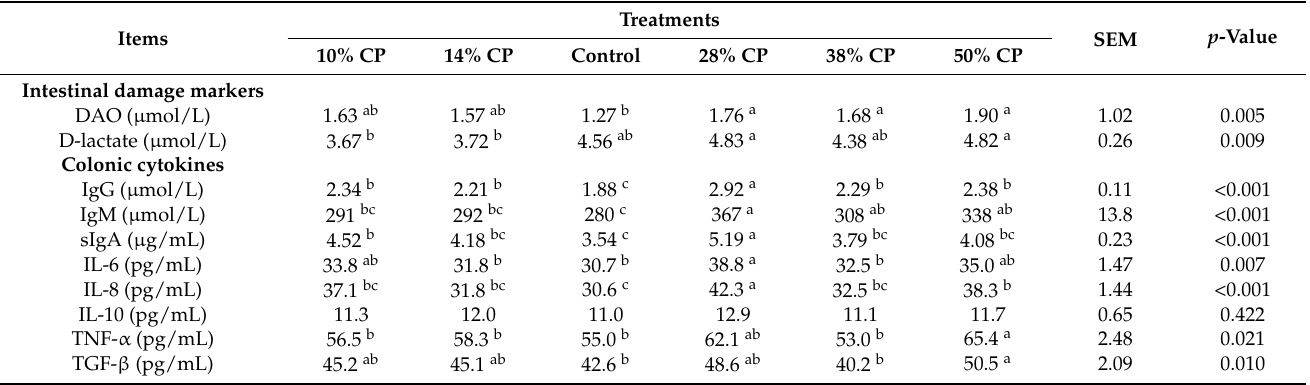
Table 2. Effects of dietary protein contents on the intestinal damage markers and colonic cytokines of SD